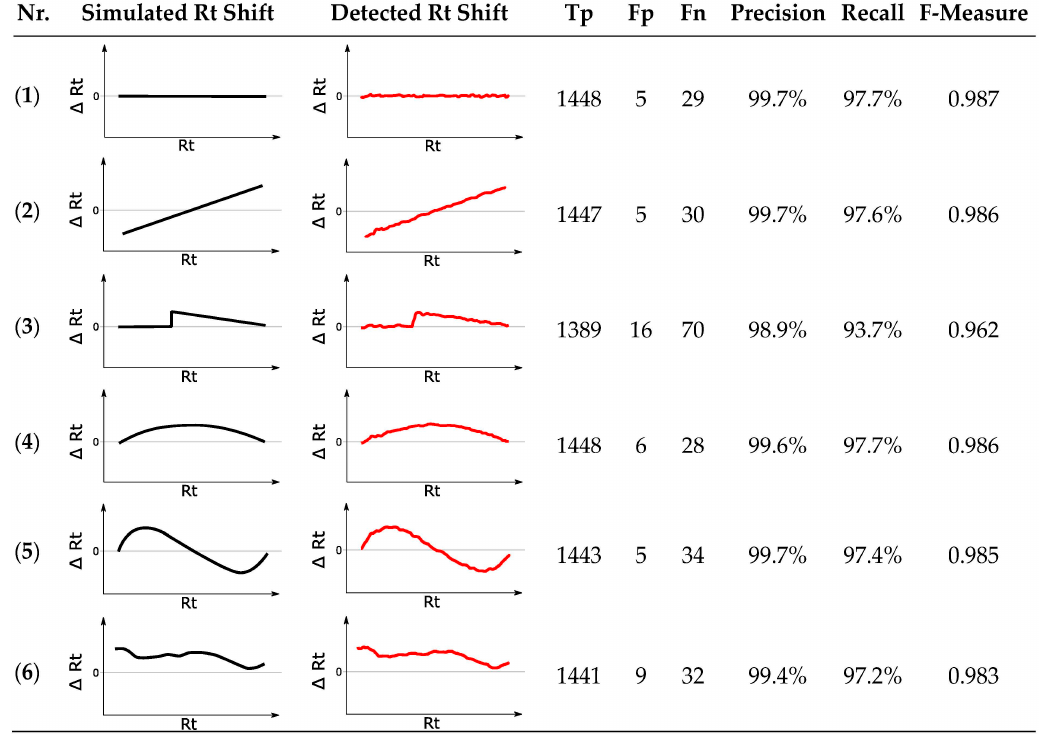
Figure 9. Results for six different simulated retention time (Rt) shifts. The reference chromatogram was matched to six modified feature lists, displaying artificially modified Rt shifts visualized by the black curves. The Rt shifts obtained by MetMatch are shown in red. ( 1 ) No Rt shift apart from random ± 6 s; ( 2 ) Monotonically increasing linear Rt shift; ( 3 ) Discontinuous Rt shift, as may, e.g., happen by a defective LC pump; ( 4 ) Non-linear Rt shift without inflection; ( 5 ) Non-linear Rt shift with inflection; ( 6 ) Complex non-linear Rt shift based on the type of Rt shift observed in the real-world wheat experiment.